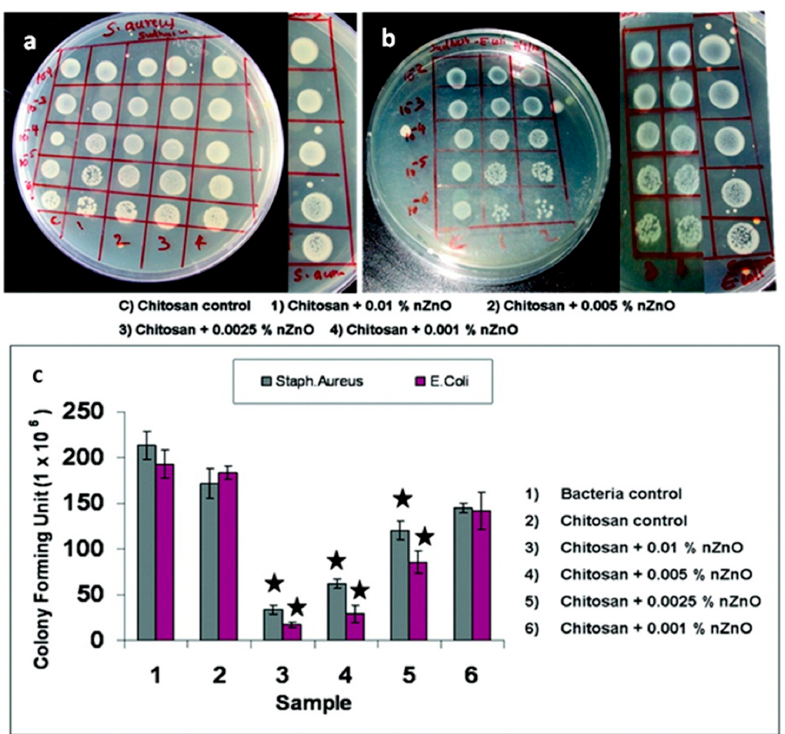
Figure 18. Photographs showing the antibacterial activity of composite bandages against ( a ) S. aureus and ( b ) E. coli . ( c ) Quantification of the antibacterial activity (Star symbols represent the p < 0.05 level, indicating that the means are significantly different, compared with the control). Adapted with permission from reference [24]. Copyright (2012) American Chemical Society.